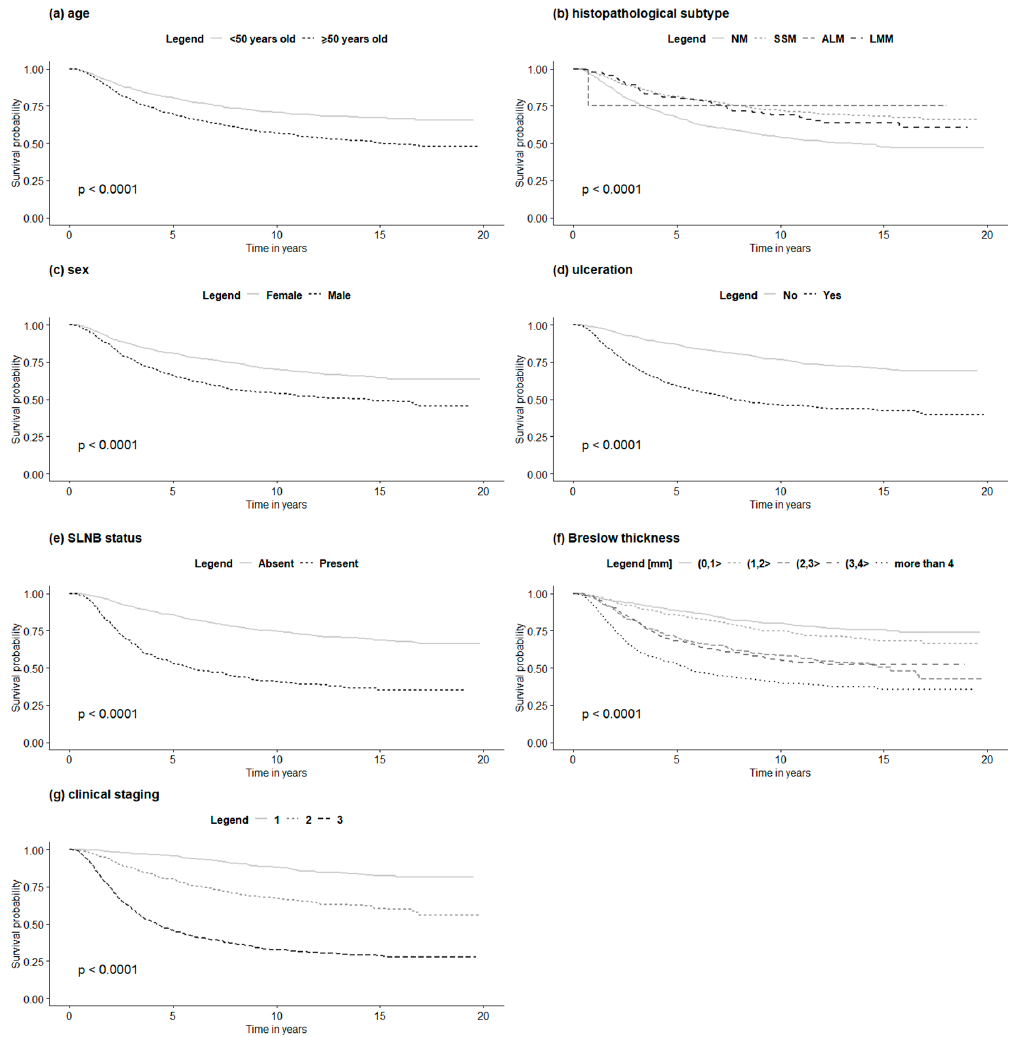
Figure 3. OS in non-HFM patients according to clinicopathological features: ( a )—age, ( b )—histopathological subtype, ( c )—SLNB status, ( d )—sex, ( e )—ulceration, ( f )—Breslow thickness, ( g )—clinical staging. Legend: OS—overall survival, non-HFM—non-hand and foot melanoma, SLNB—sentinel lymph node biopsy, NM—nodular melanoma, SSM—superficial spreading melanoma, ALM—acral lentiginous melanoma, LMM—lentigo malignant melanoma.